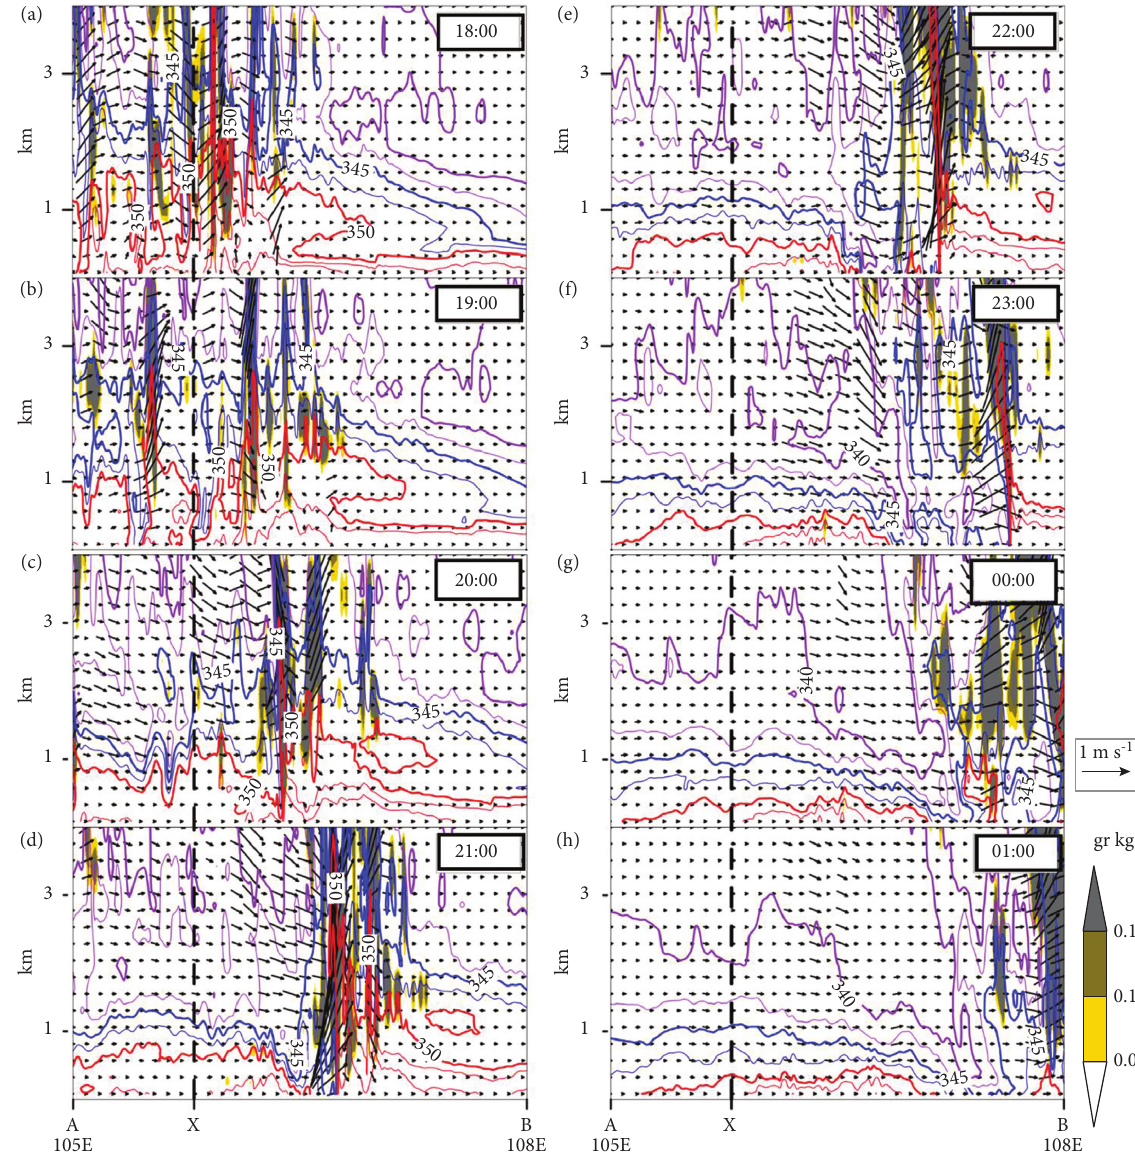
Figure 8: Vertical-longitude cross section of wind (vector; zonal component multiplied by a factor of 0.01), equivalent potential temperature (contour), and cloud mixing ratio (shaded) along the thick black line from point A to point B in Figure 6(b) with time evolution for (a-h) 18: 00–01:00 LST. The x -axis is longitude representing the distance of A-B transect. The black vertical dotted line (X) indicated the coastal line. For clarity, the equivalent potential temperatures ( θ e ) are differenced as contour lines with red for θ e ≥ 350K, blue for 350 > θ e ≥ 345K, and purple for 345 > θ e ≥ 340K. The purple contour line over near surface ( < 1 km) indicated a cold